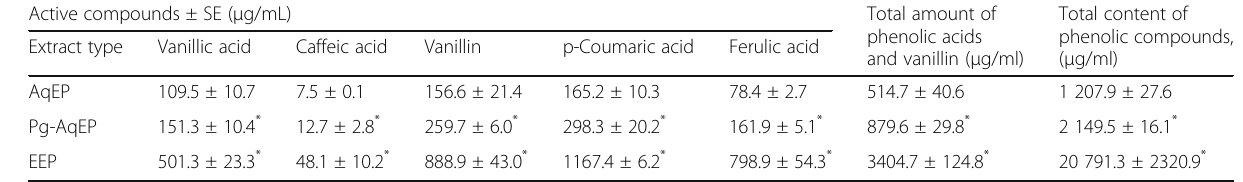
Table 1 Quantity of identified active compounds in aqueous, polyethylene glycol-aqueous and ethanolic propolis